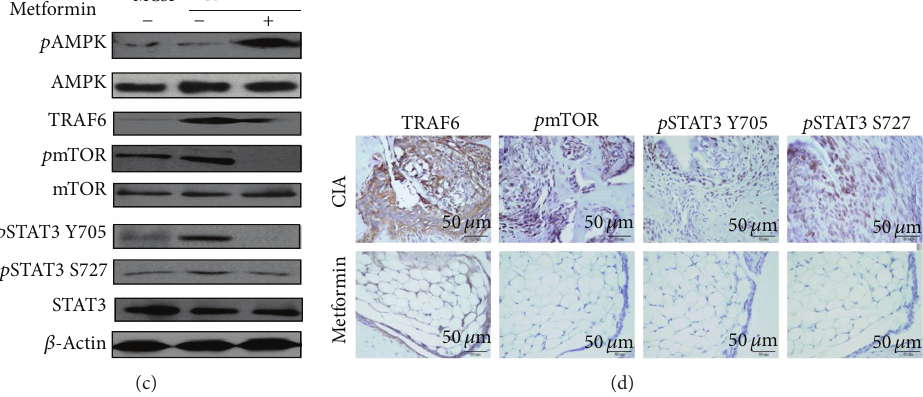
Figure 5: Metformin suppresses osteoclastogenesis in vitro . C57BL/6 mice preosteoclasts were cultured in the presence of 10ng/mL M-CSF and/or 50 ng/mL RANKL in the presence or absence of metformin 1mM. (a) Differentiated osteoclasts were stained for TRAP (scale bar = 200 𝜇 m) and The TRAP+ cells were indicated in graph (under). (b) The mRNA levels of TRAP, MMP-9, calcitonin receptor, carbonic anhydrase II, cathepsin K, integrin 𝛽 3, HIF1- 𝛼 , and AMPK were quantified by real-time PCR. (c) Protein levels of p AMPK, TRAF6, p mTOR, mTOR, p STAT3 Y705, p STAT3 S727, STAT3, and 𝛽 -actin were analyzed using Western blot in osteoclasts. (d) Immunohistochemical detection of TRAF6, p mTOR p STAT3 Y705, and p STAT3 S727 were stained in the synovium of CIA and metformin-treated CIA. All tissues were